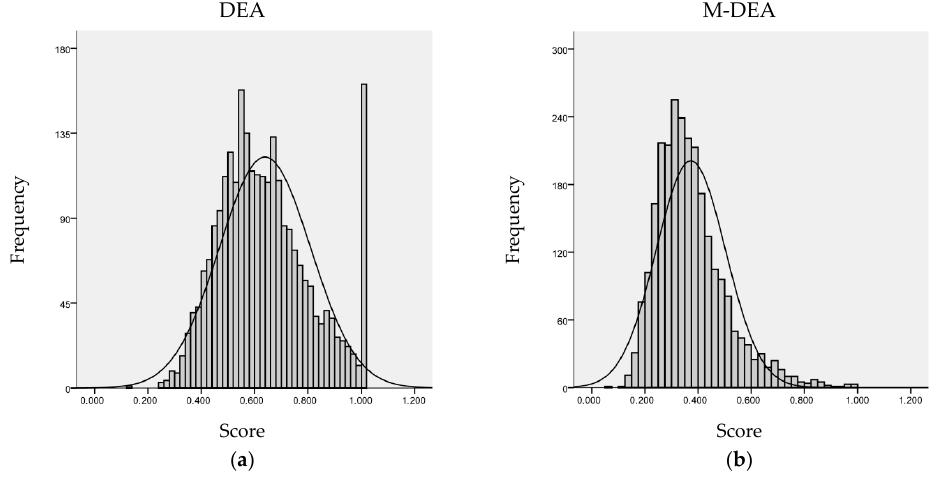
Figure 4. Frequency distribution of the efficiency index of the DEA ( a ) and M-DEA ( b ) models without outliers for 2008 and 2016.